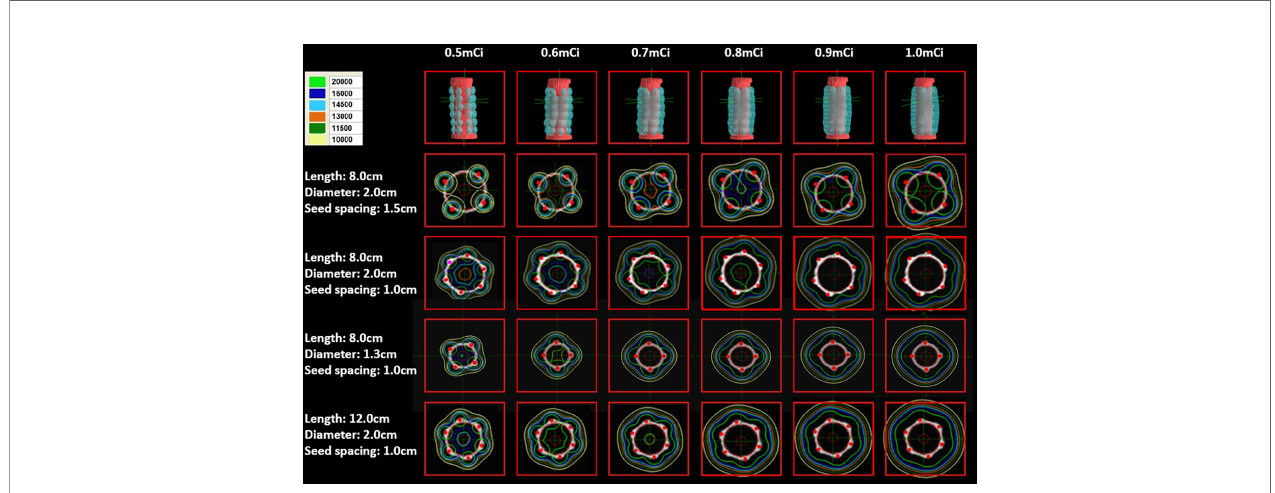
FIGURE 2 | The higher the seed activity, the higher the dose. Both the conformability and the uniformity of the isodose lines produced by a seed spacing of 1.0 cm were superior to those produced by a seed spacing of 1.5 cm, the latter also showed a few dosimetric “ cold spots ” . The dose coverage was good with seed spacing of 1.0 cm and seed activity ≥ 0.6